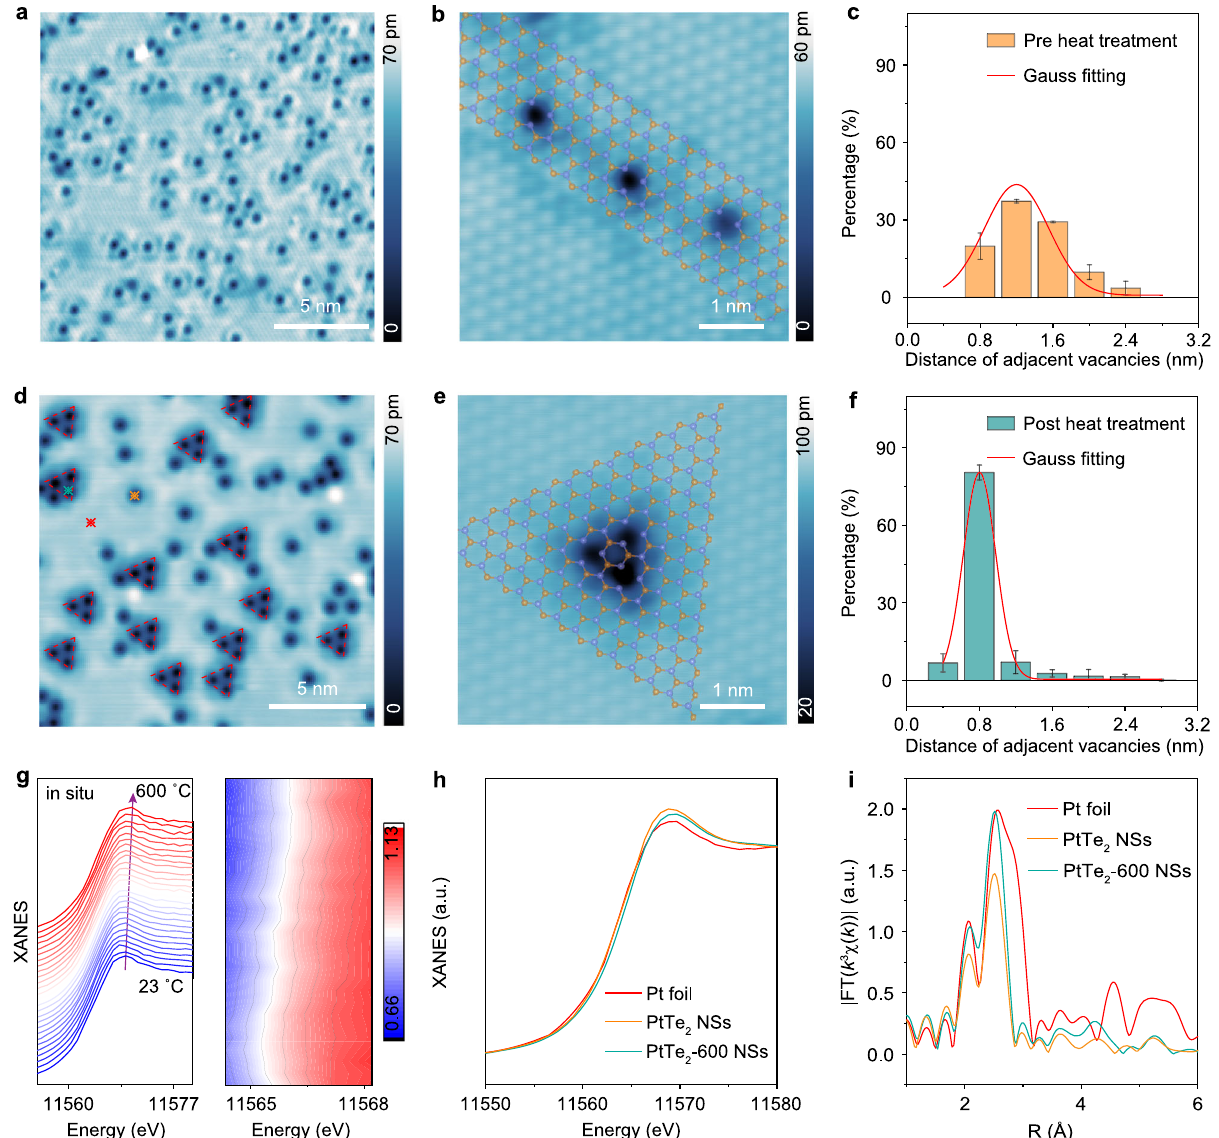
Fig. 2 Heat treatment-induced migration of Te-SAVs in PtTe 2 . a Large-scale STM image of thin PtTe 2 sheets taken at V S = − 2.0 V and I = 30 pA. b Close-up STM image showing three individual Te-SAVs on the surface of thin PtTe 2 sheets with the corresponding structural model superimposed. The yellow and blue atoms represent Te and Pt atoms, respectively. Te atoms at the bottom of PtTe 2 structural model are omitted. c Statistic distance of neighboring Te-SAVs in thin PtTe 2 sheets before heat treatment. d Large-scale STM image of thin PtTe 2 sheets after heat treatment. e Close-up STM image showing the formation of ordered trigonal Te-SAV clusters on the surface of thin PtTe 2 sheets after heat treatment with the corresponding structural model superimposed. Te atoms at the bottom of PtTe 2 structural model are omitted. f Statistic distance of neighboring Te-SAVs in thin PtTe 2 sheets after heat treatment. The error bars in c and f represent standard deviation of different technical replicates. g Stacking plots of the in situ Pt L 3 -edge XANES spectra of PtTe 2 NSs collected from room temperature to 600 °C in He gas (left), and the corresponding 2D contour plots of the in situ Pt L 3 -edge XANES spectra as shown in g (right), revealing the positive shift of the white line. h Normalized Pt L 3 -edge XANES spectra for PtTe 2 NSs, PtTe 2 -600 NSs, and Pt foil. i Fourier-transformed k 3 -weighted EXAFS spectra for PtTe 2 NSs, PtTe 2 -600 NSs, and Pt